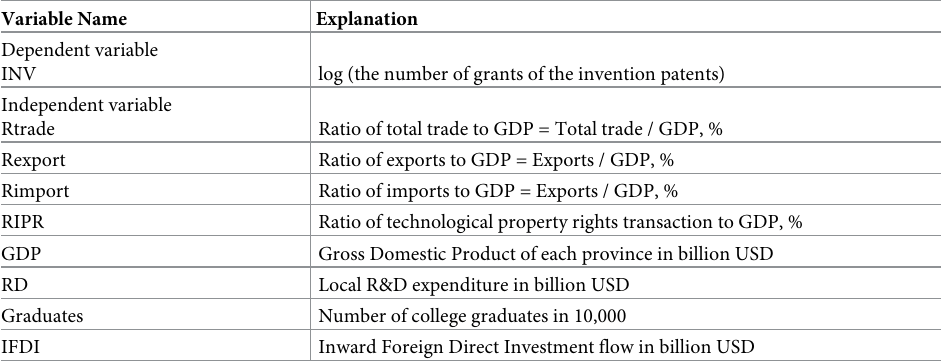
Table 1. Definition of key